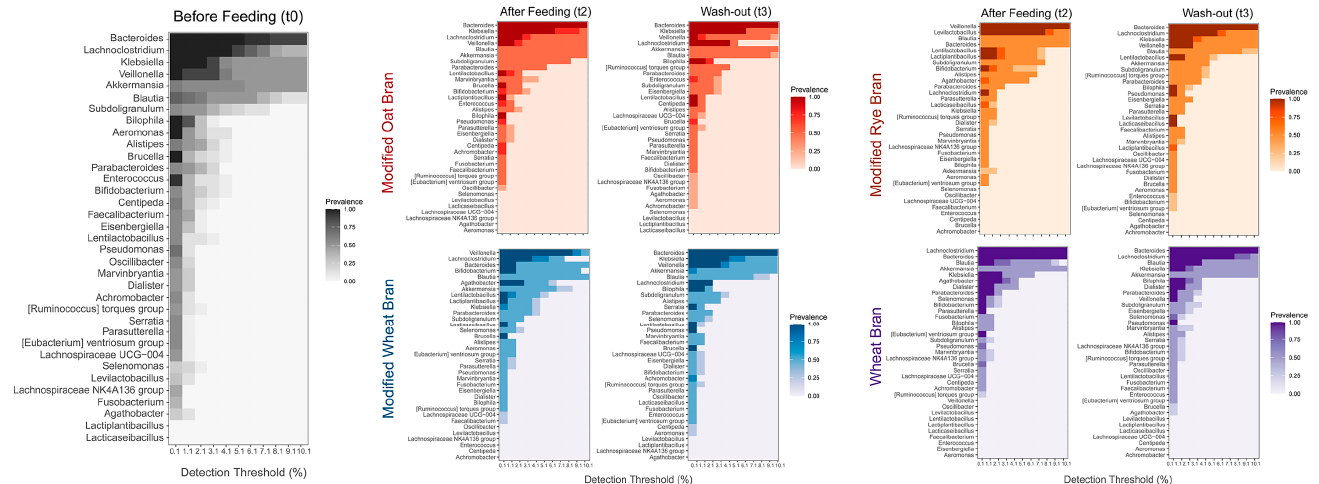
Figure 5. Pseudo-heatmaps showing the prevalence of aggregated core bacterial microbiota at genus level before (t0) and after two weeks (t2) of feeding with different formulations, and after two weeks of wash out period (t3). The color scales (gray for t0, red, orange, purple and blue for SHIME ® units fed with MOB, MRB, MWB, and WB, respectively) indicate the prevalence of OTU abundances across different detection thresholds ranging from 0.1 to 10.1%. For each pseudo-heatmap the term “modified” before the kind of AXOS means hydrolyzed and fermented by lactic acid bacteria. All sequencing results are publicly available at EML/NCBI/DDBJ under the accession date 10 August